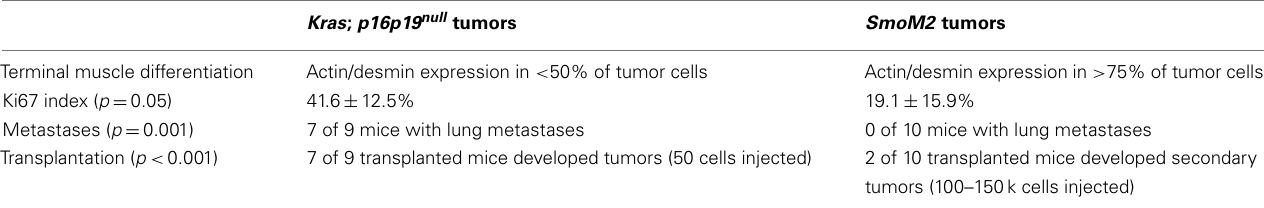
Table 1 | Differences in the malignant behavior of Kras; p16p19 null and SmoM2 mouse tumors .